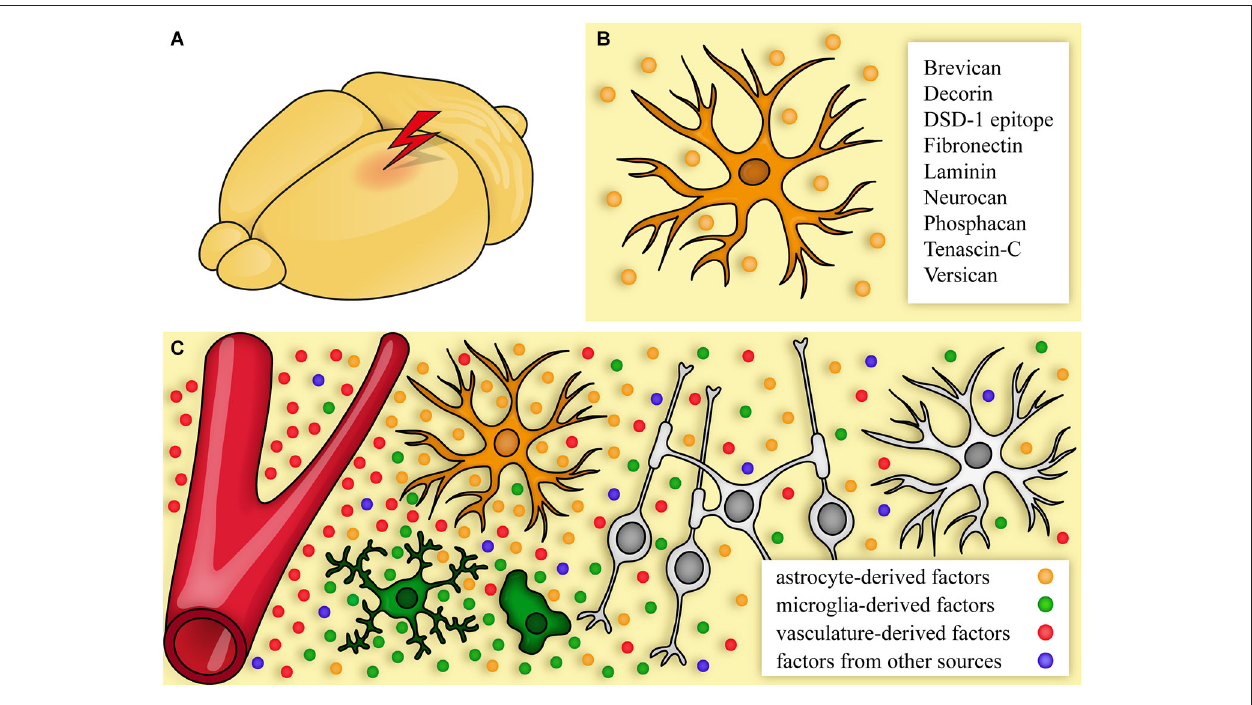
vasculature (red), immune cells/microglia (green), and additional sources (blue, for a detailed list see Table 1 ). This environment can promote, but also inhibit regeneration by affecting neurons, astrocytes, and